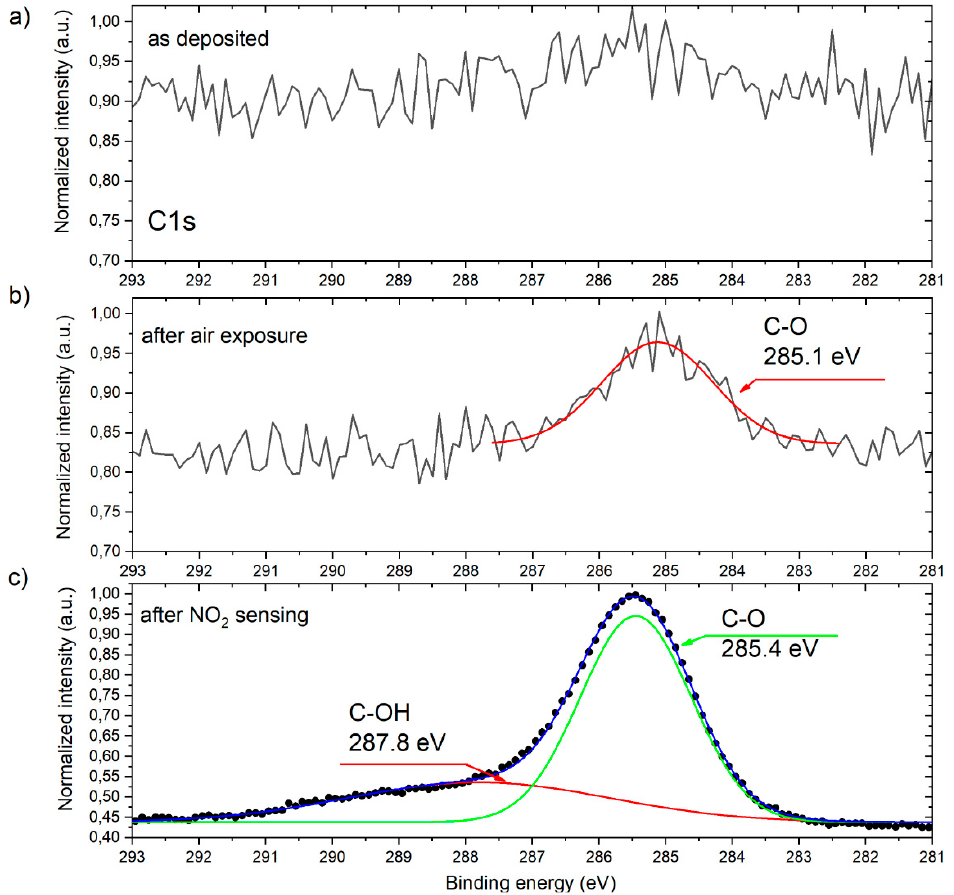
Figure 5. C1s spectral window for RGVO SnO x nanolayers: ( a ) as deposited; ( b ) after air exposure; ( c ) after NO 2 sensing experiments.